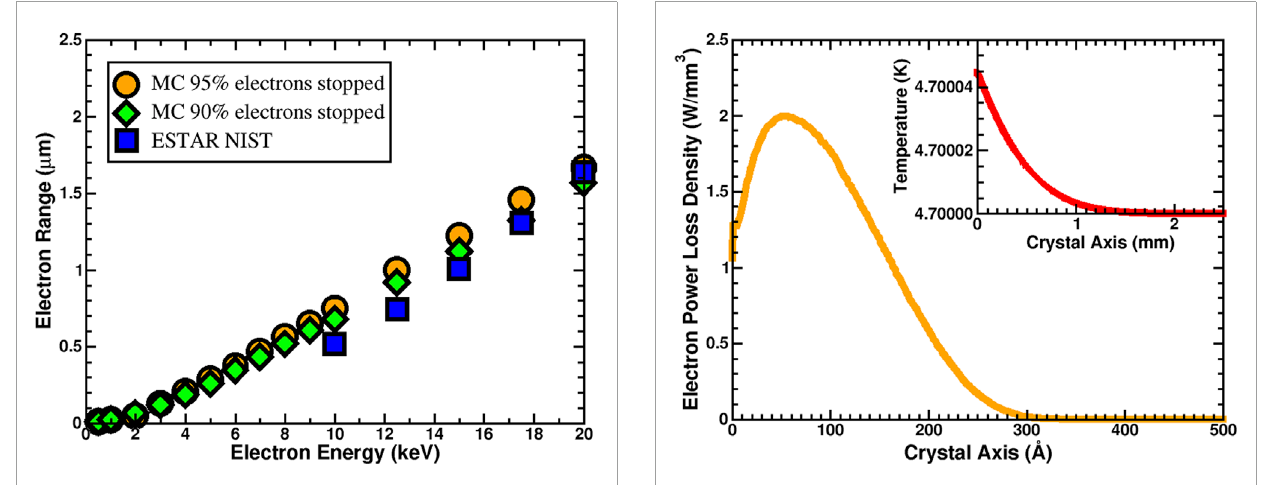
BymodifyingtheMonteCarlosimulationtoalsotrackwherethe electronslosetheirenergywithinthecopperhost,theheatingprofile